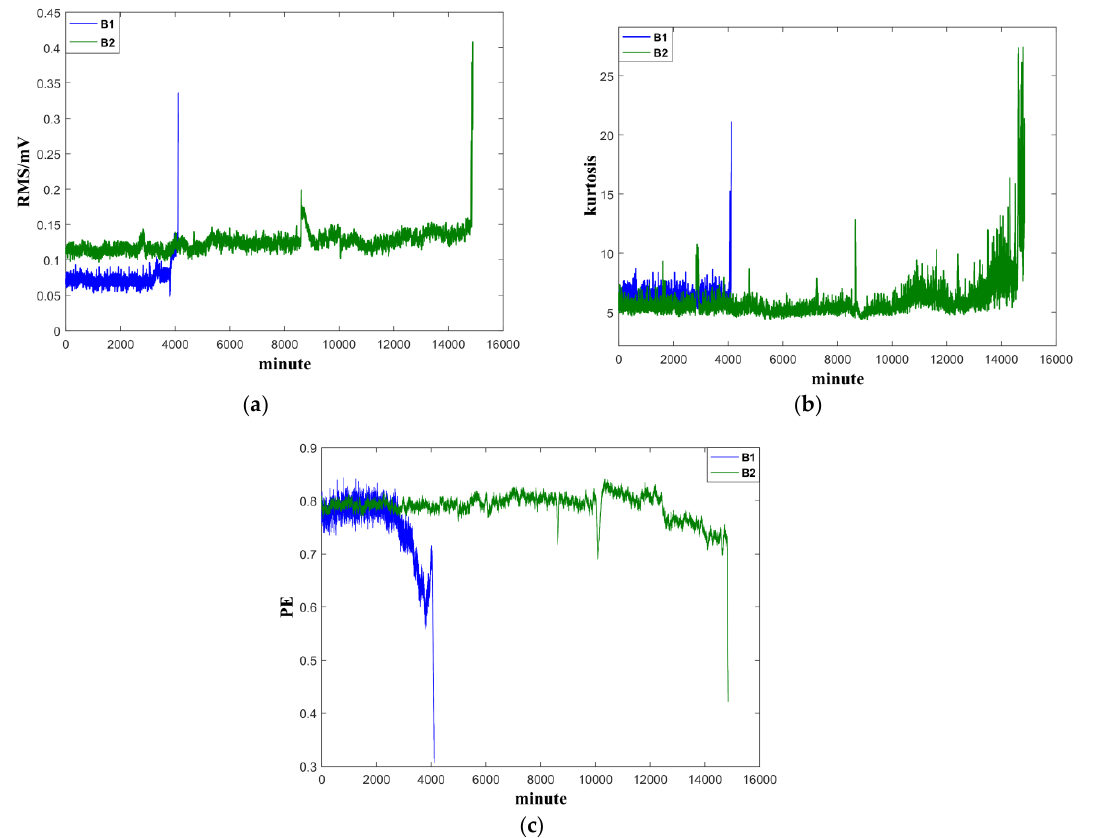
Figure 6. Features of the tested bearings on their full cycle life: ( a ) RMS, ( b ) kurtosis, ( c ) PE. The normal-state data (200 units) are used to establish a healthy status GMM model. Several trials show that a GMM with 5 Gaussian components is sufficient to model the normal-state data. We implemented a prior experiment that used more than 5 Gaussian components (6,7,8) and the results